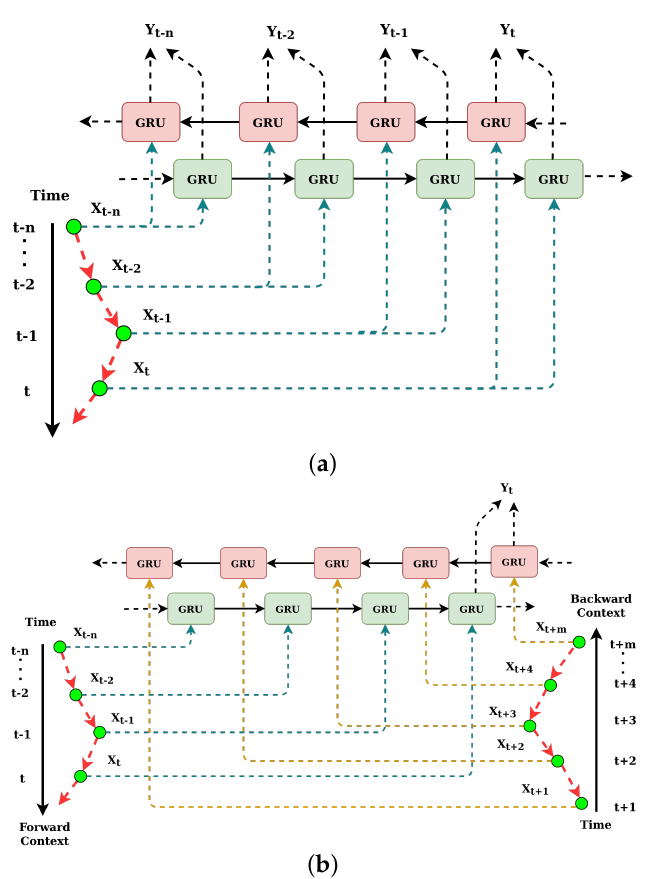
Figure 2. A network of bidirectional GRU ( a ) contexts with similar lengths and ( b ) contexts with different length.